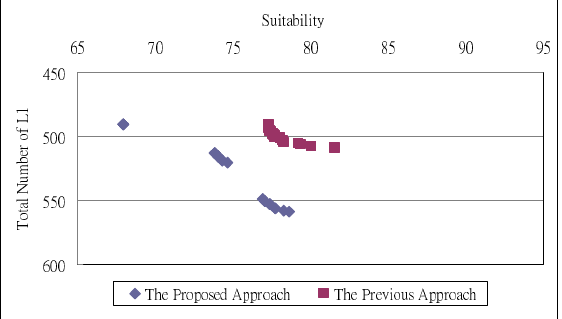
Fig. 9. Comparison results of the final Pareto fronts for the exponential dataset